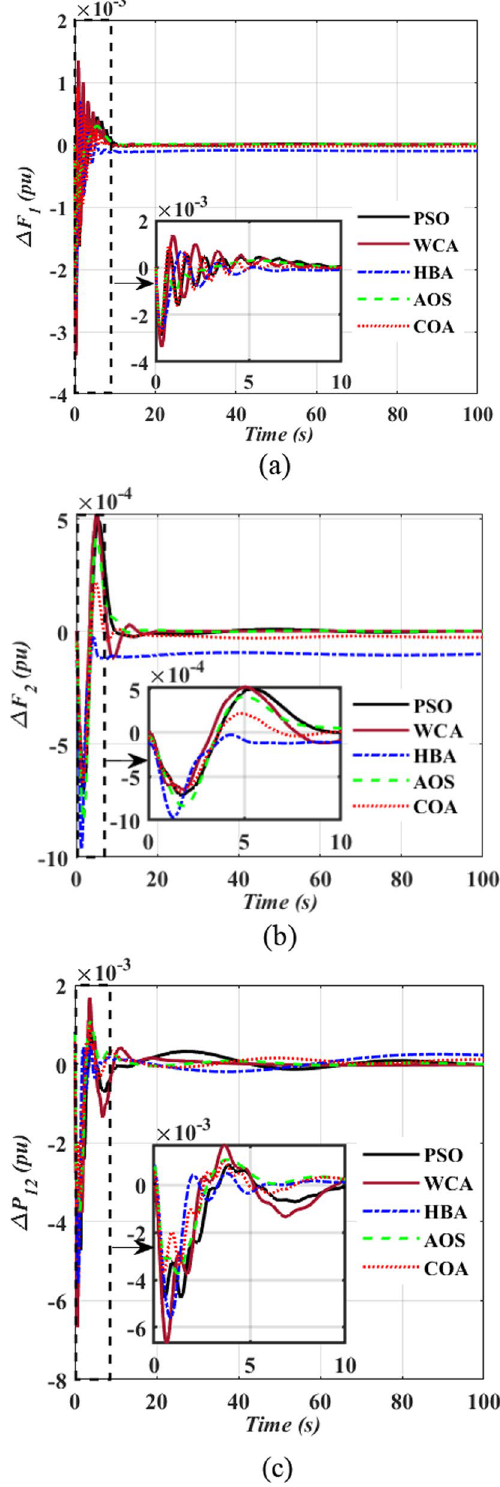
Fig. 10 System responses due to 1 while including FOPID controller a (cid:31) F 1 , b (cid:31) F 2 , c (cid:31) P 12